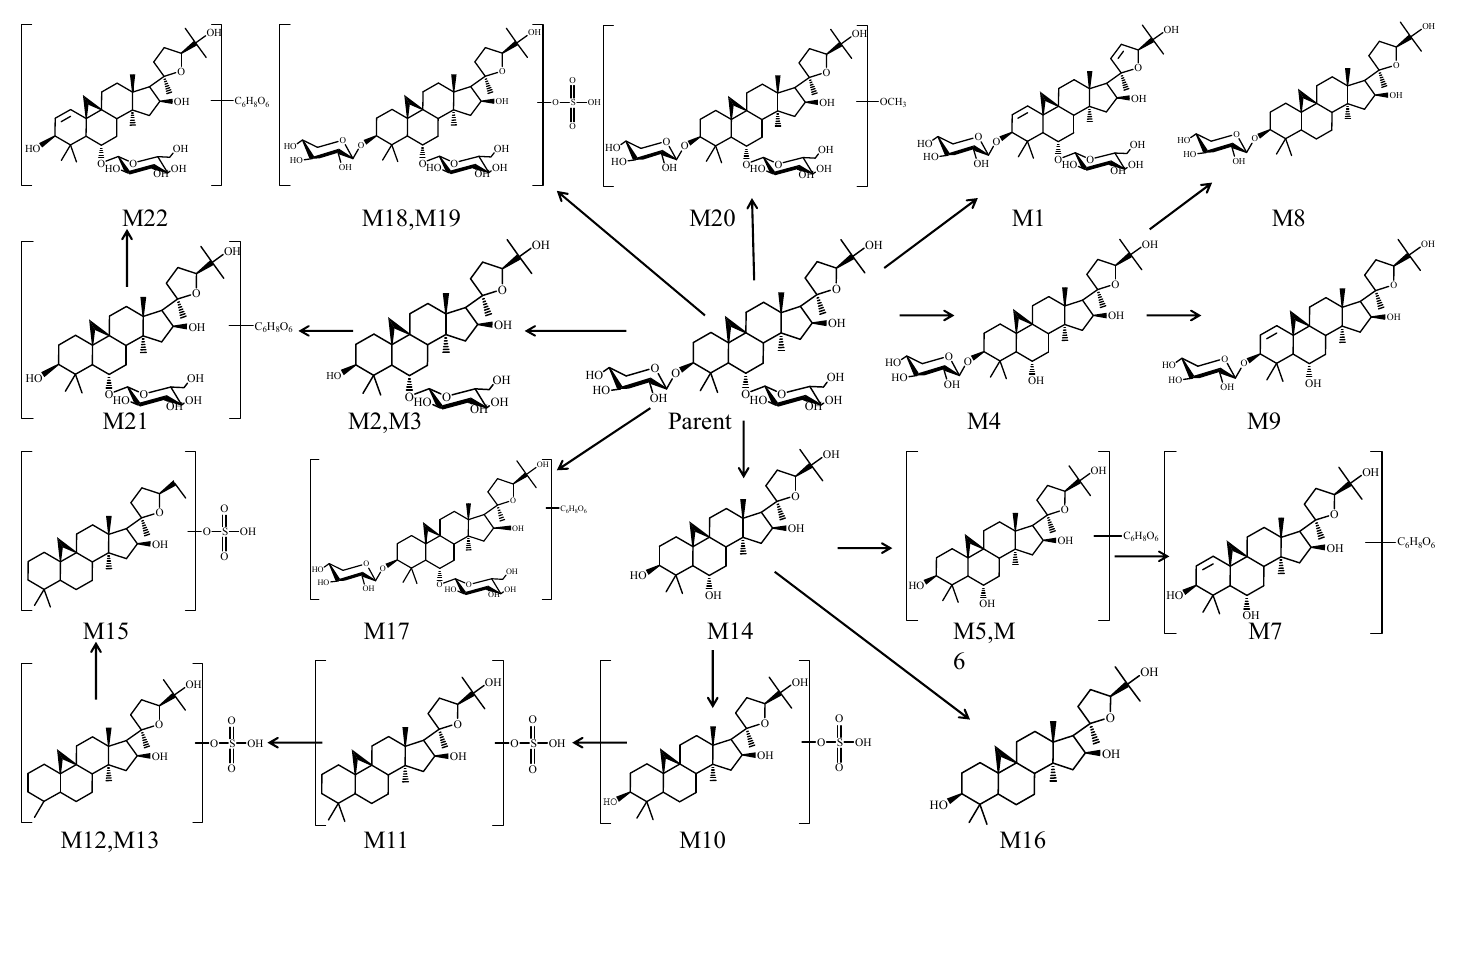
Figure 4. Proposed major metabolic pathway of astragaloside